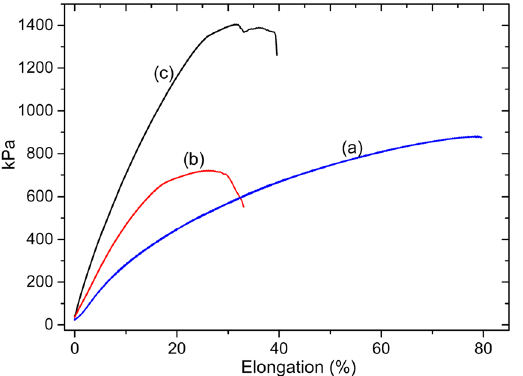
Figure 9. Stress-Strain (%) behavior of PPOB 40 -B-al 40 -S 20 ( a ), cut-healed specimen ( b ), only heat treated specimen ( c ).